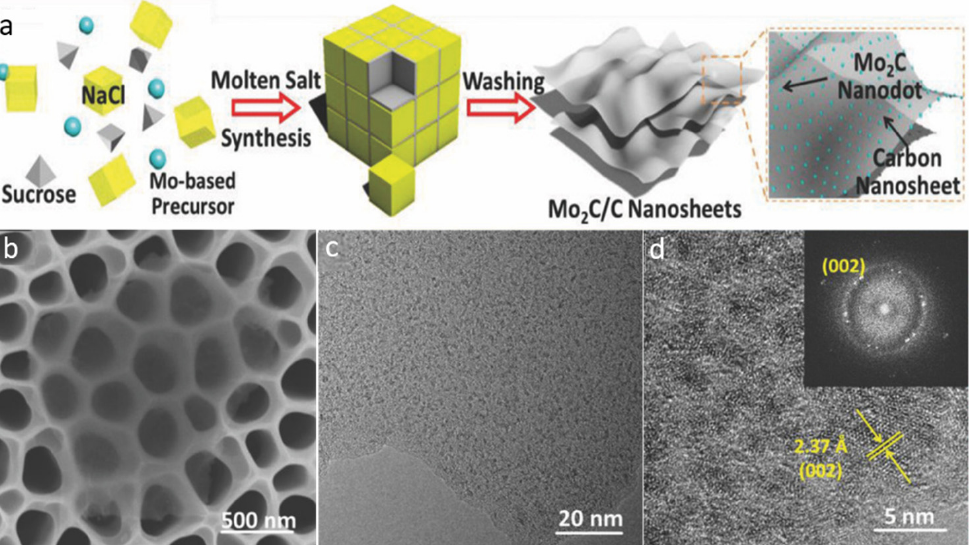
Figure 7. ( a ) Schematic for the fabrication of Mo 2 C/C nanosheets via molten salt method. ( b ) SEM micrograph, ( c ) TEM micrograph, and ( d ) HR-TEM micrograph with the inset showing the fast-Fourier-transform (FFT) pattern of the Mo 2 C/C nanosheets. Reproduced with permission from ref. [74] Copyright 2018, Wiley.